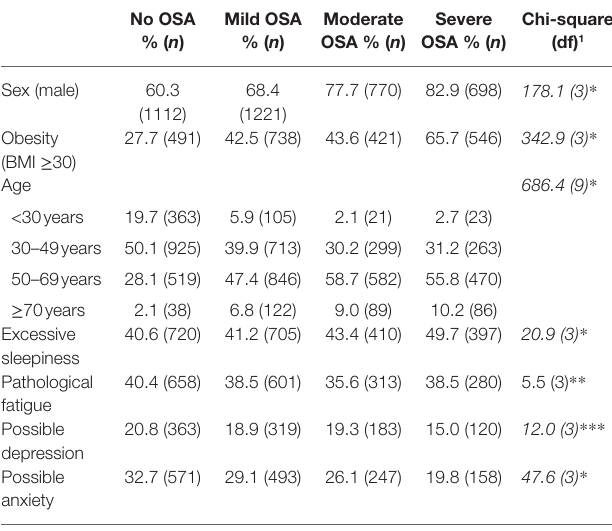
TABLE 2 | Associations between different severity levels of obstructive sleep apnea (OSA) and sex, body mass index (BMI), age, excessive sleepiness, pathological fatigue, possible depression, and possible anxiety, respectively, in patients referred with suspected sleep apnea to the Centre for Sleep Disorders at Haukeland University Hospital in Bergen, Norway ( n =